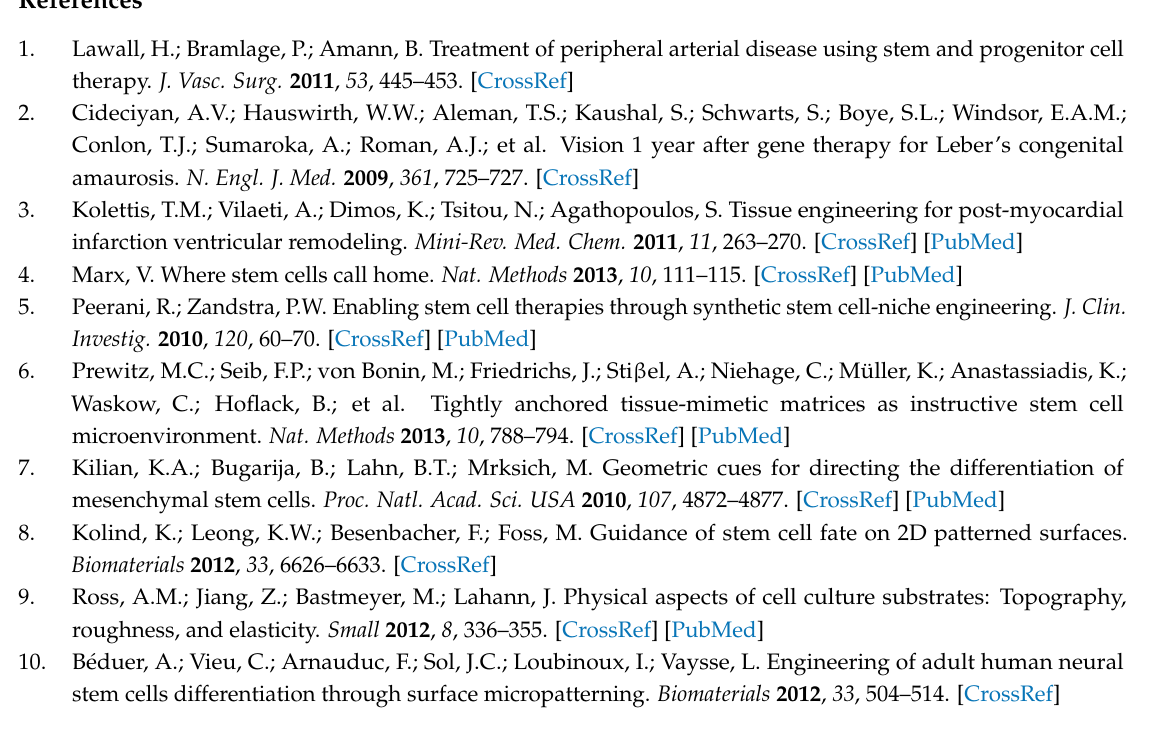
Figure S3: Histograms representing the deviation angle of cell nuclei with respect to the trend angle on the patterned-PLLA surfaces (GROOVES 1 and GROOVES 2) after 1 and 14 cultivation